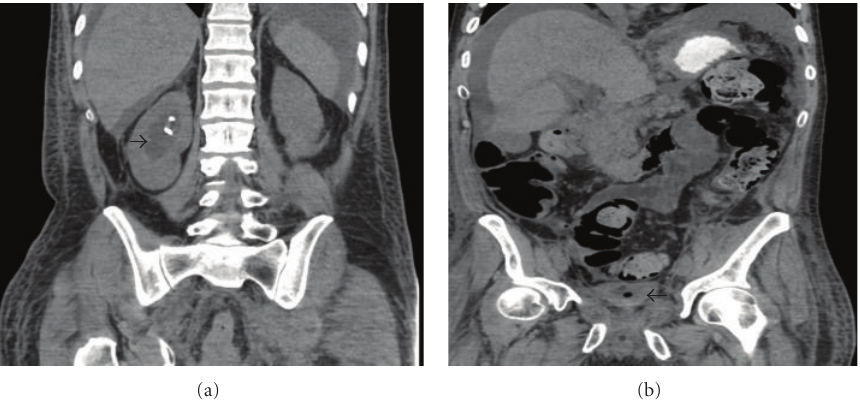
Figure 2: Images from our institution showing a thickened bladder wall (arrowhead on the right) and right-sided nephrosis (arrowhead on the left).